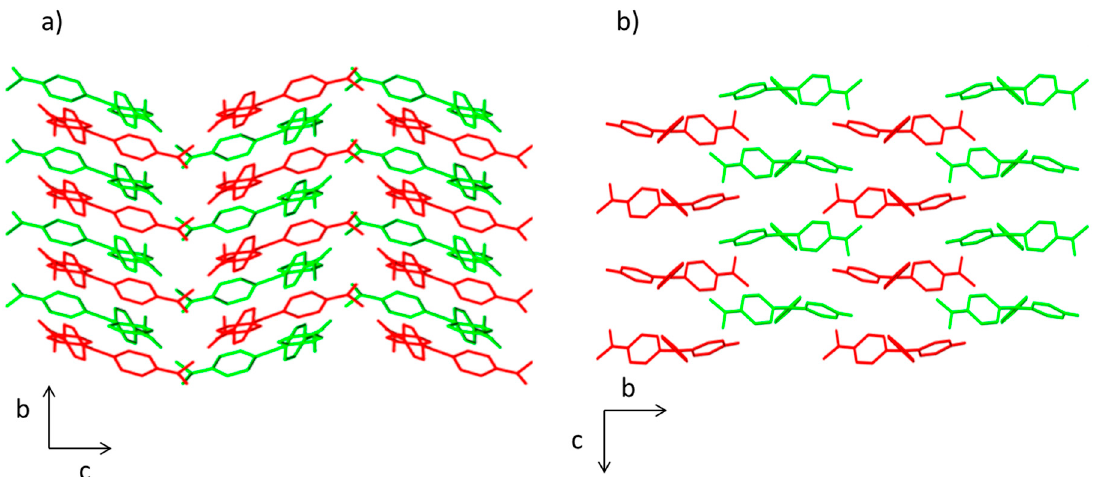
Figure 2. View of the packing diagram along a axis for ( a ) compound 1 and ( b ) compound 2 . Hydrogen atoms have been omitted for clarity.